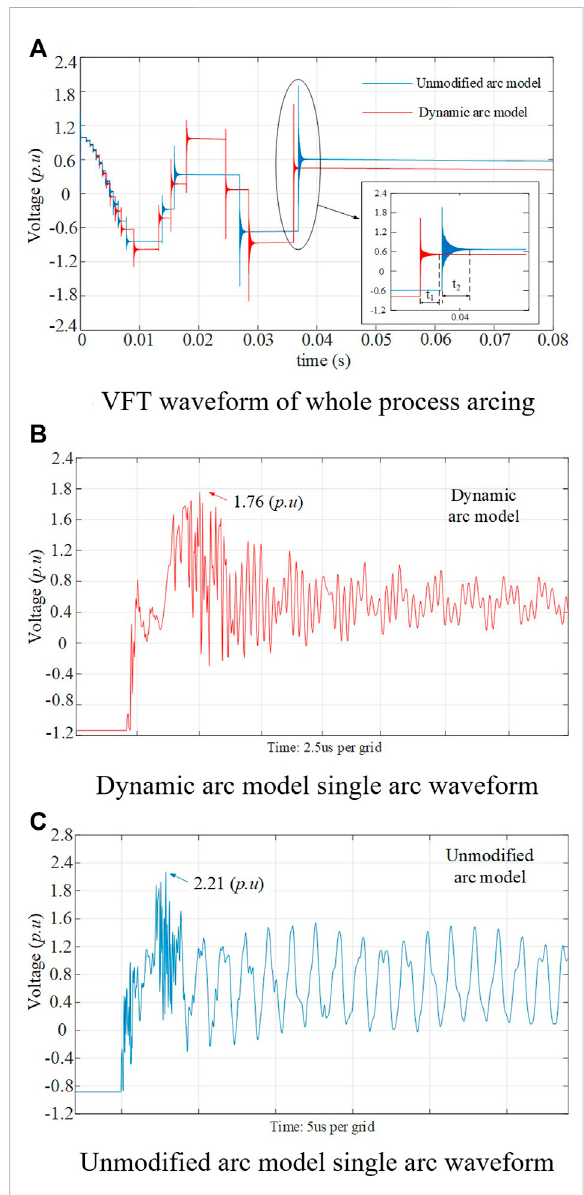
FIGURE 9 Comparison of VFT simulation results under different arc models. (A) VFTwaveformofwholeprocessarcing (B) Dynamicarc model single-arc waveform (C) Unmodi fi ed arc model single-arc